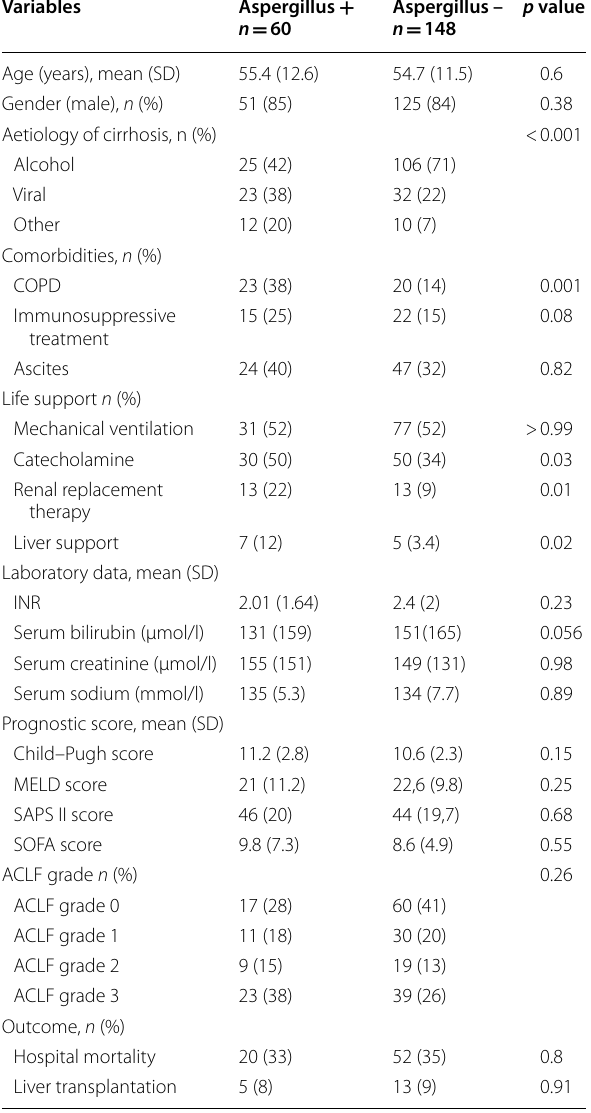
clinical and laboratory ) positive culture of −